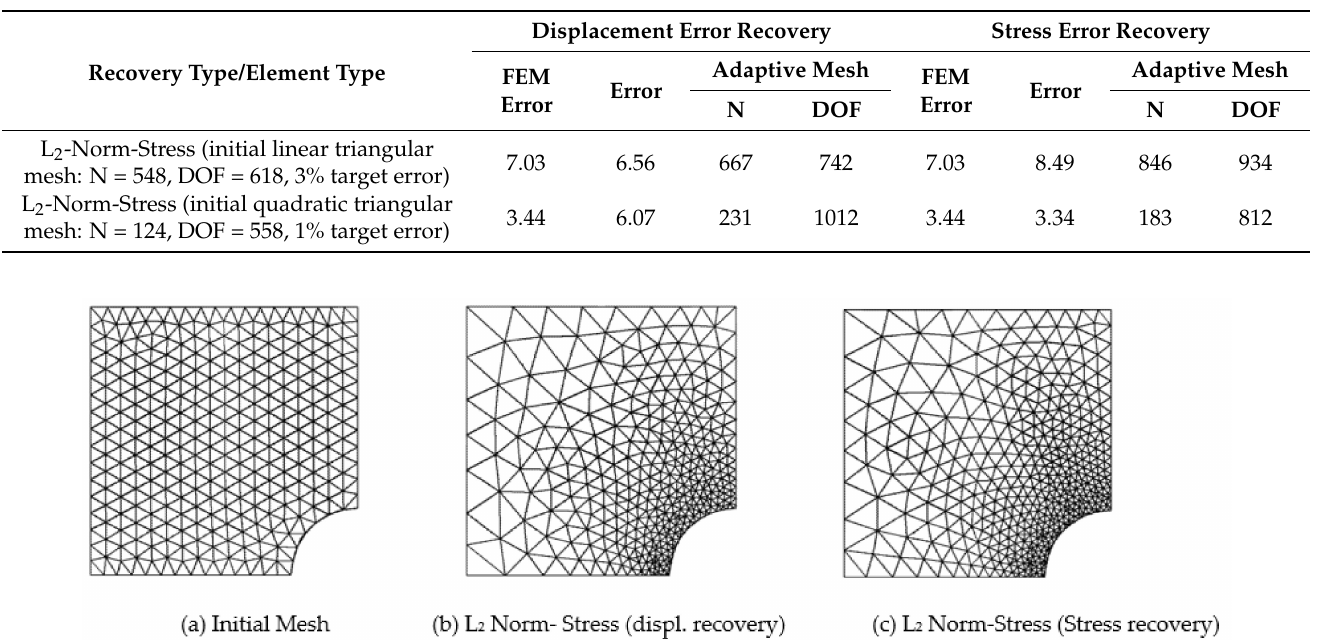
Table 9. Global errors (FEM and processed L 2 -Norm) and number of element (N) with DOF of adaptively refined meshes considering displacement and stress recovery-based analysis.